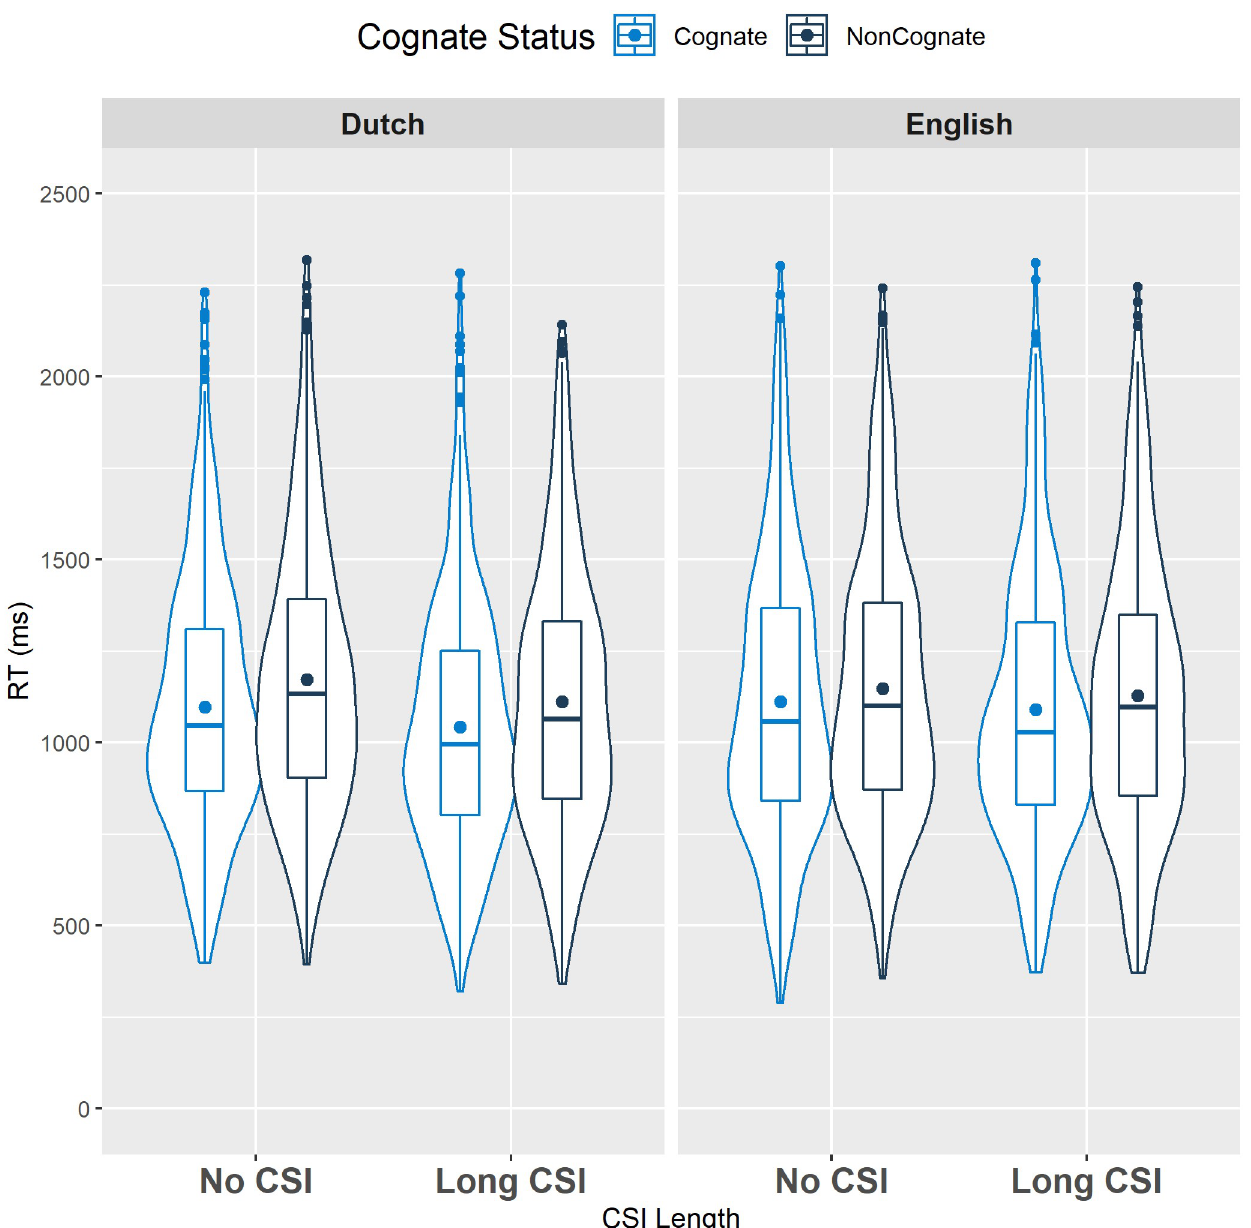
Fig 1. Violin plot showing the distribution of cognate and non-cognate RTs in each CSI block across both varieties in Experiment 1 (Dutch/English bilinguals). The boxplots show the interquartile range, the horizontal line represents the median, and the dot indicates the mean for each condition.